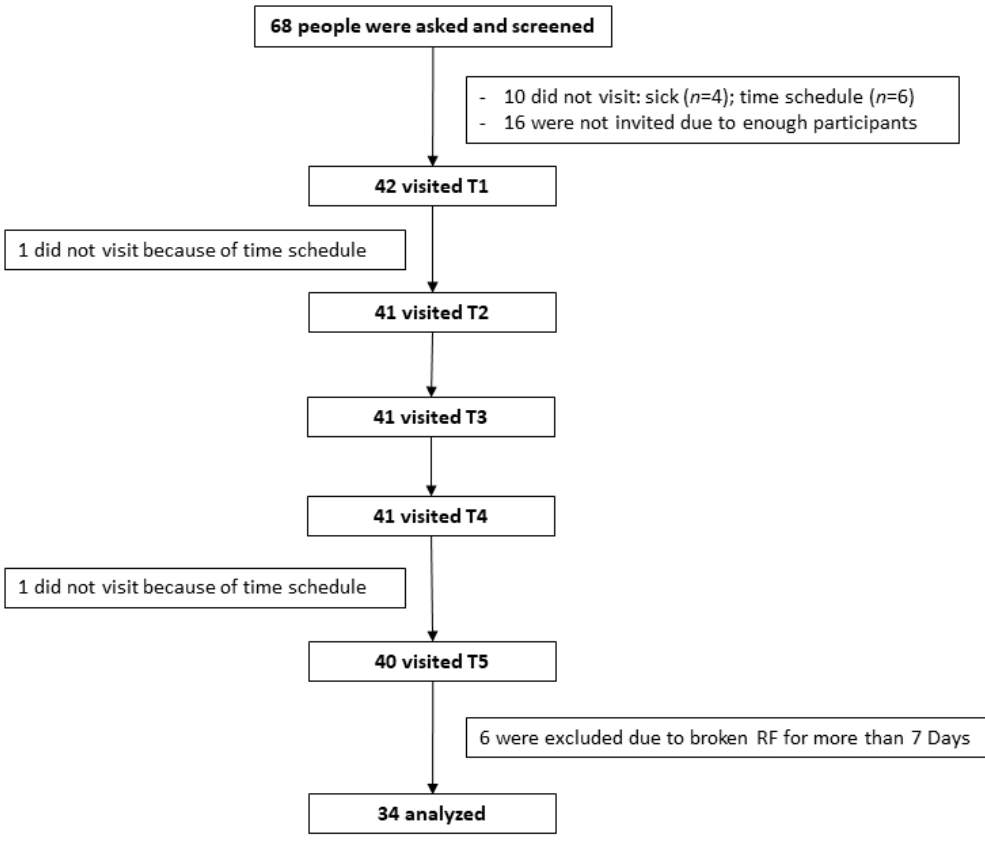
Figure 1. Flow chart recruitment of participants.